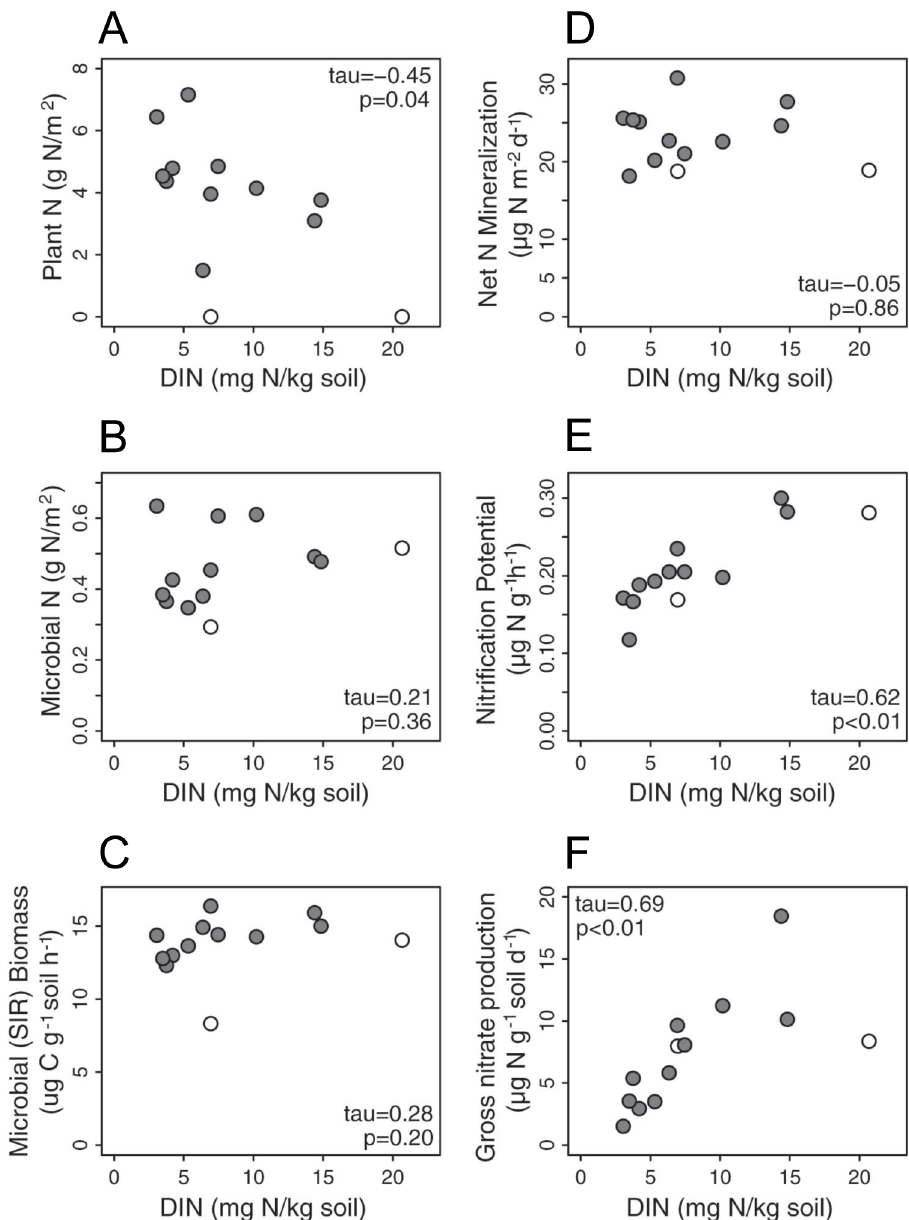
Figure 3. Comparison of soil DIN and plant and microbial metrics. A total plant N, B Microbial N, C Microbial biomass measured by substrate induced respiration (SIR), D Potential net N mineralization, E Nitrification potential, and F Gross nitrification for monocultures and bare plots. White dots represent bare and bare seeded plots, grey dots are vegetated plots.